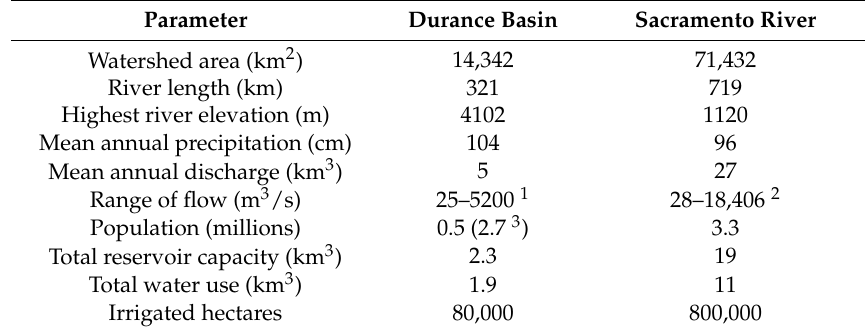
Table 2. The Durance and Sacramento Rivers share a Mediterranean climate and other characteristics, yet differ in other